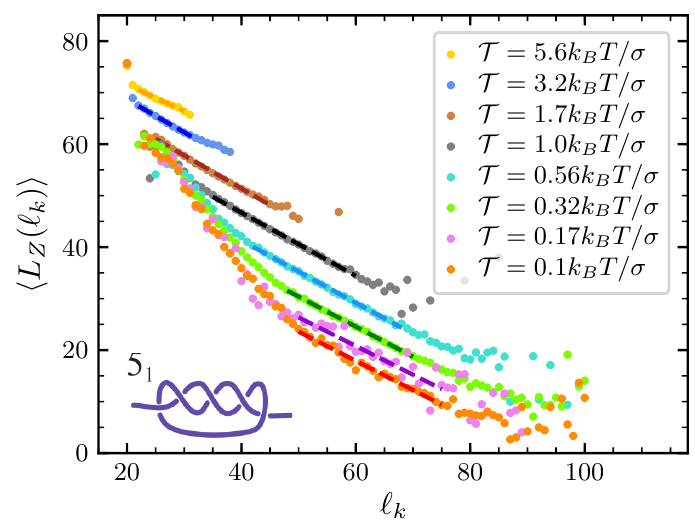
Figure A2. Same as in Figure A1 but in the case of the 5 1